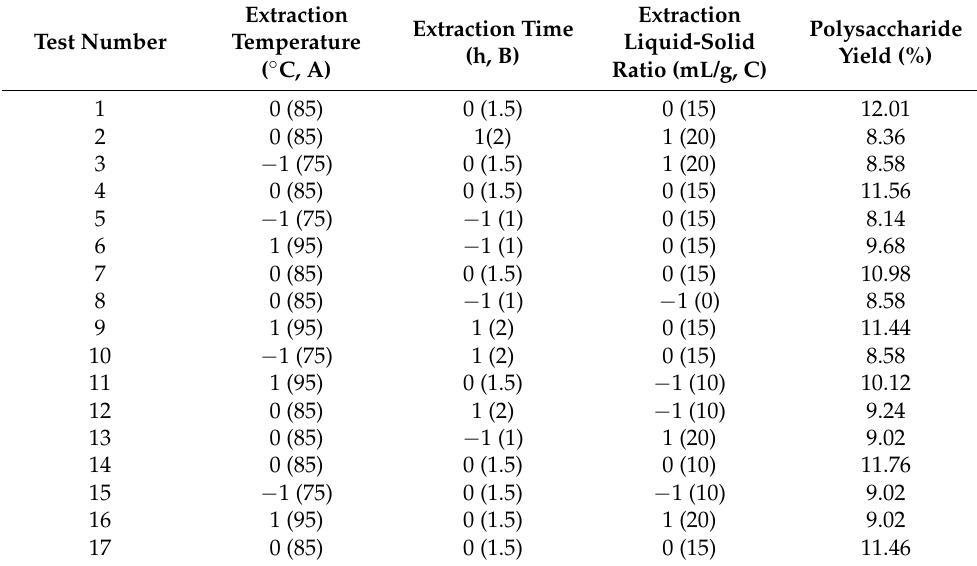
Table 1. Box-Behnken test design and results.